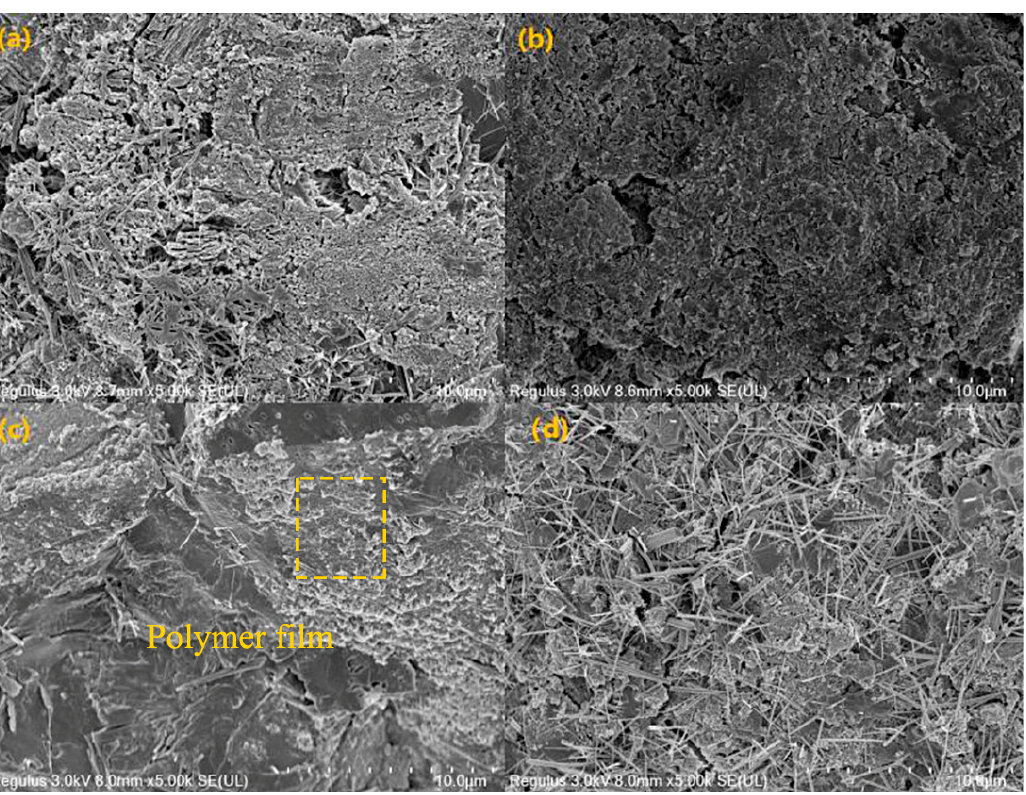
Figure 14. SEM images of hydrated products with SISBR latex powders. ( a ) Pure cement, ( b ) SISBR-1 latex cement sample, ( c ) SISBR-3 latex cement sample, ( d ) SISBR-5 latex cement sample.